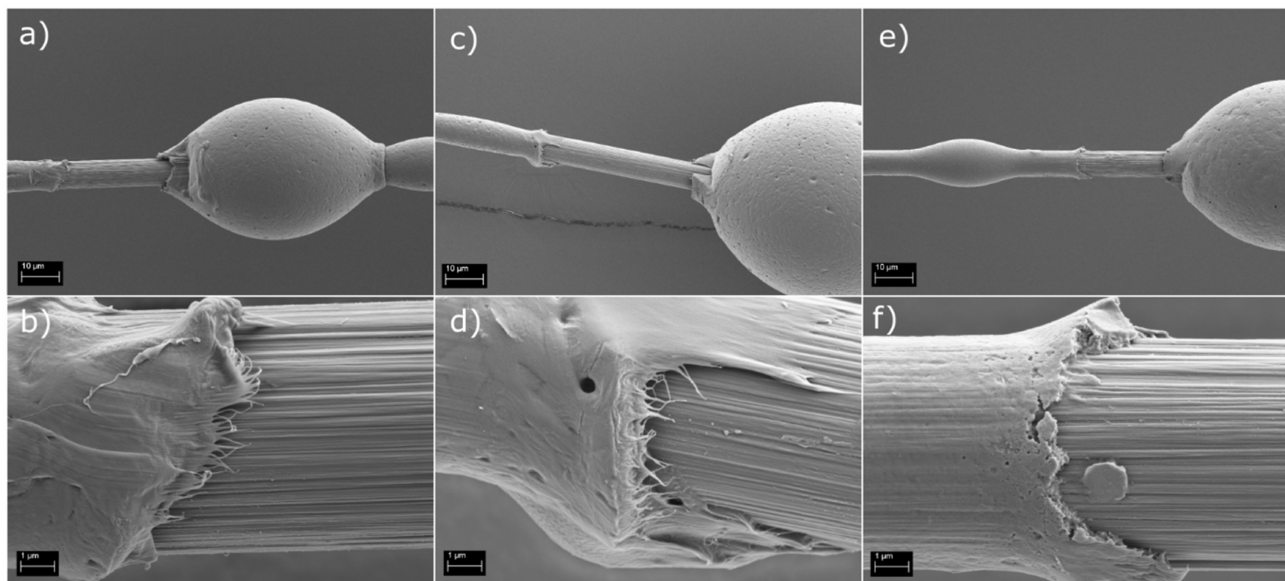
Figure 4. Fracture surfaces of ( a , b ) CF, ( c , d ) CF + 1 wt% FF solution, and ( e , f ) CF + 5 wt% FF solution, in the PP